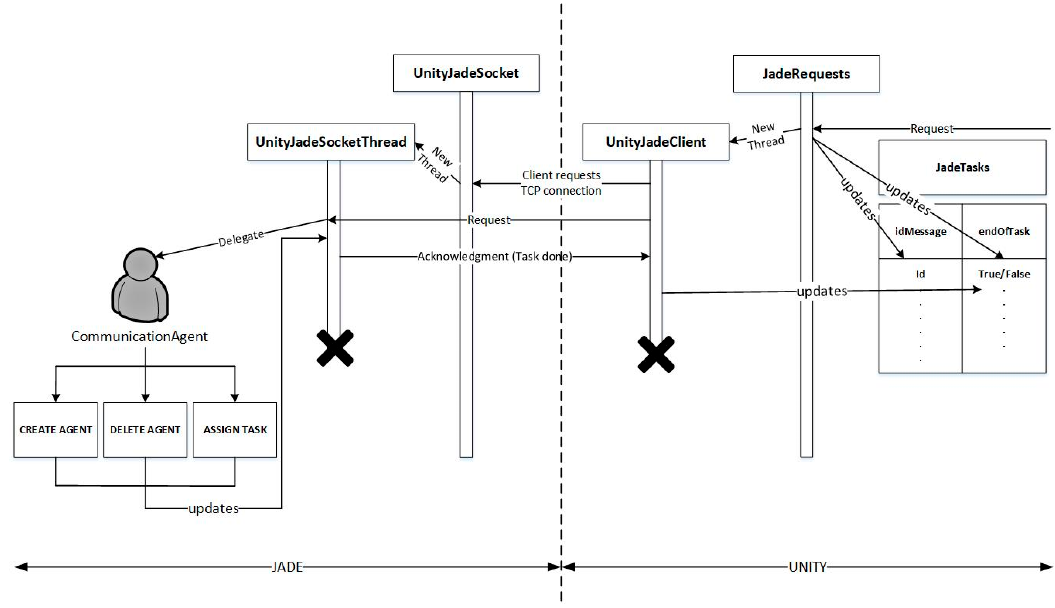
Figure 8. Unity-JADE communication.